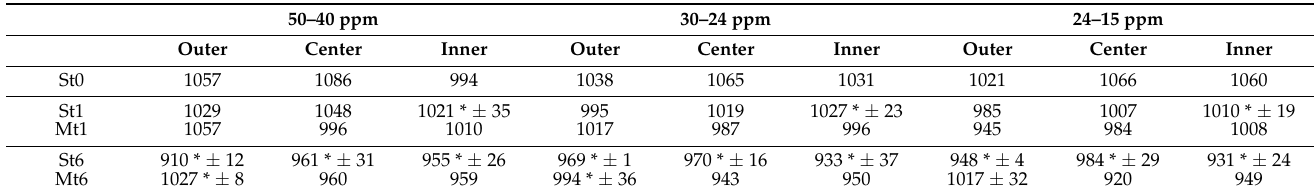
Table 2. 1 H-Spin-lattice relaxation time T 1H (ms) of carbons in the polypropylene polymer of the outer, center and inner layer of single-use face masks before (t0), after 1 month (t1) and 6 months (t6) of incubation as cuts from a single layer (S) or from a complete mask (M). Standard deviations between 1 and 37 ms were determined for duplicates.